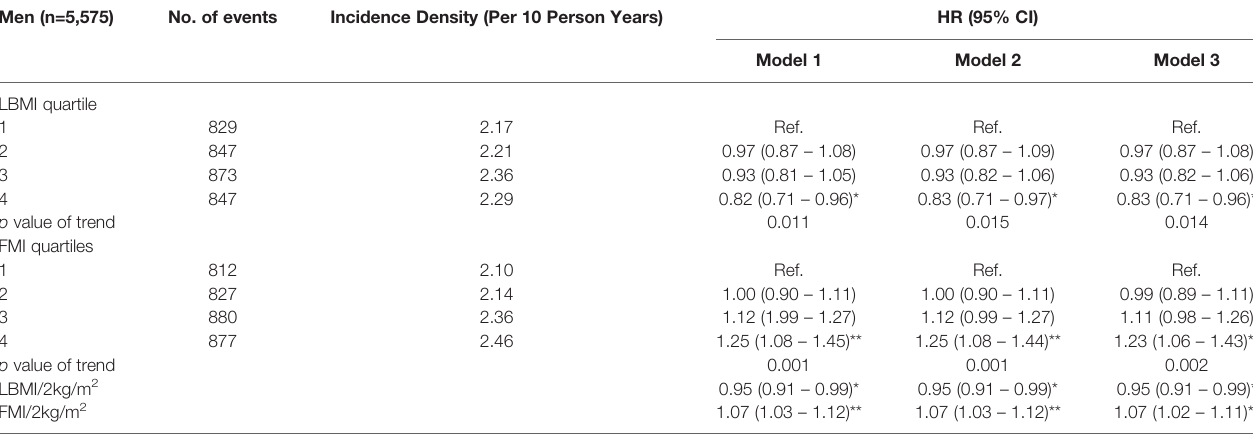
TABLE 2 | Hazard ratios for incident DN, by predicted LBMI and predicted FMI among men with diabetes. Men